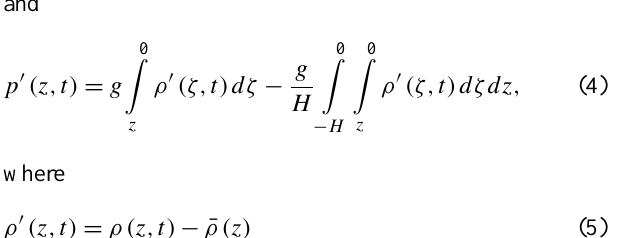
Figure 10. Vertically integrated terms in the energy flux equation, for stations Anchor West (left), Center (middle) and East (right). For example, the heavy dashed line (pressure work) in (a) is the vertical integral of Fig. 9d.